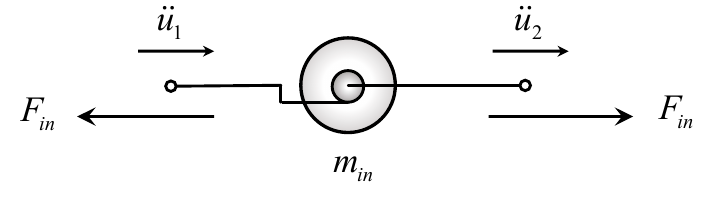
Figure 3. Mechanical model of the inerter.